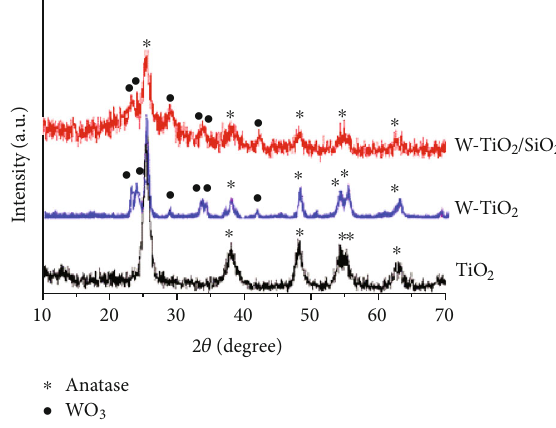
Figure 1: X-ray di ff raction patterns of TiO /SiO W-TiO 2 2